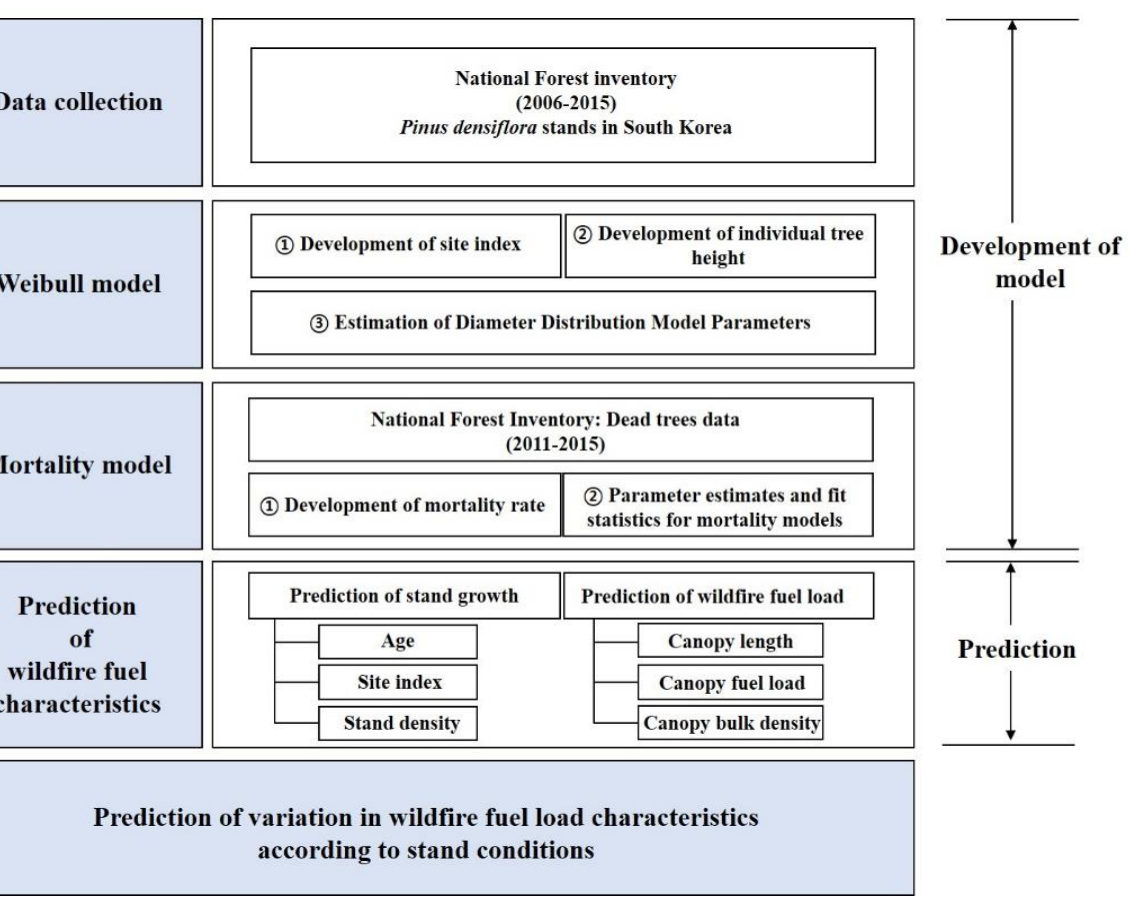
Figure 2. Schematic process flow of the study.